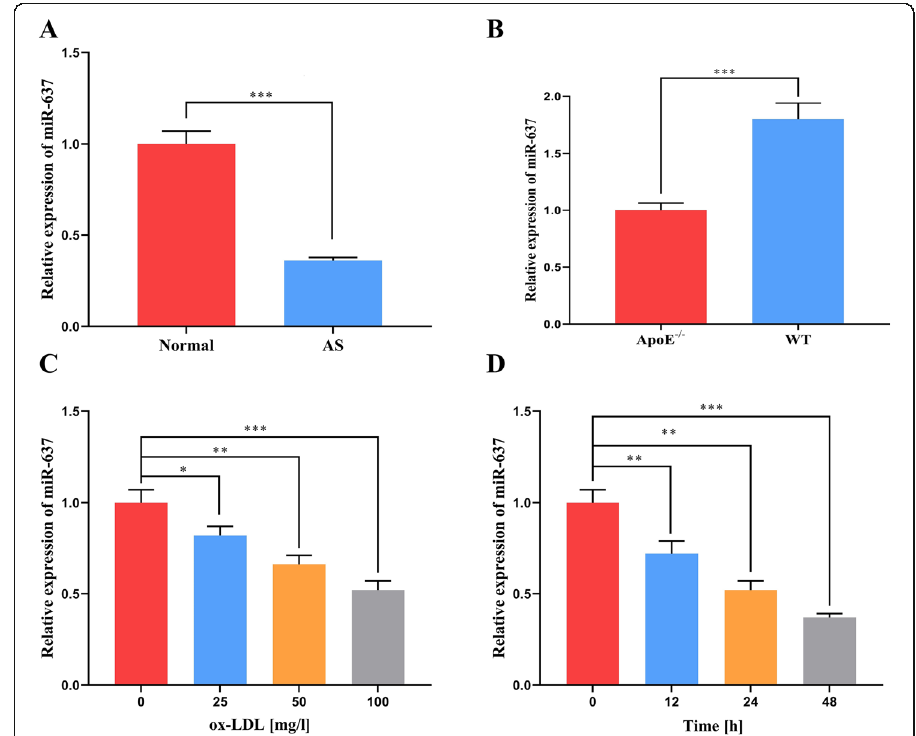
Fig. 1 miR-637 is downregulated in atherosclerosis. a and b – The expression levels of miR-637 in human plasma ( a ) and mouse plasma ( b ) were determined using real-time PCR. c and d – The expression level of miR-637 in VSMCs treated with ox-LDL was determined using real-time PCR. *, ** and *** respectively indicate p < 0.05, p < 0.01 and p <